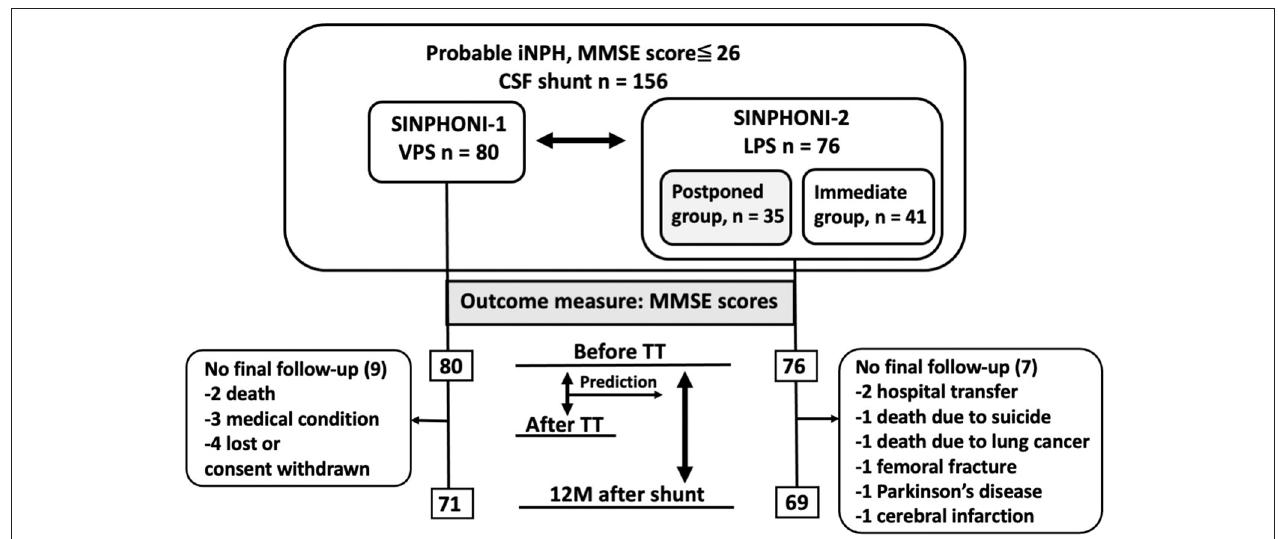
FIGURE 1 | Flow chart displaying patients with probable iNPH and MMSE scores ≤ 26 before TT. CSF, cerebrospinal fluid; LPS, lumboperitoneal shunt; MMSE, Mini-Mental State Examination; iNPH, idiopathic normal pressure hydrocephalus; TT, tap test; VPS, ventriculoperitoneal